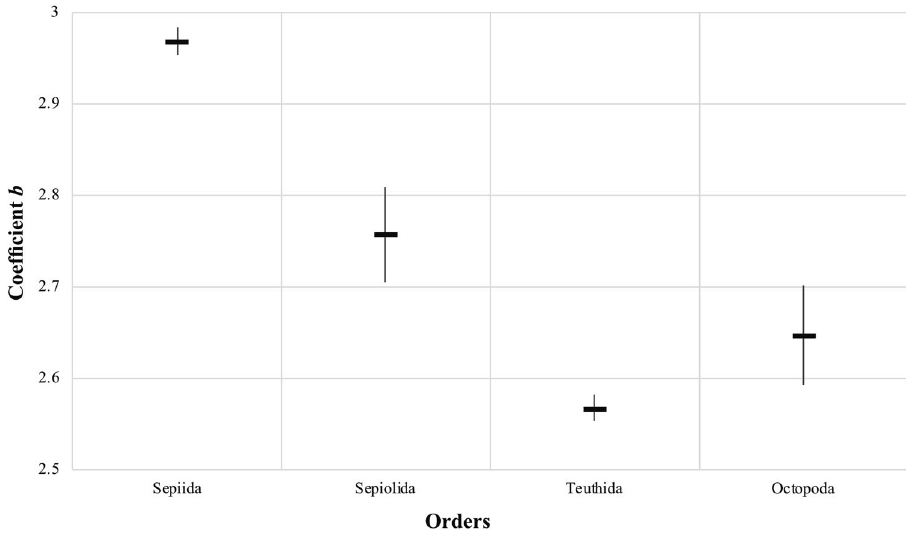
Figure 2. Coefficient b values comparison between orders with standard deviation ranges.